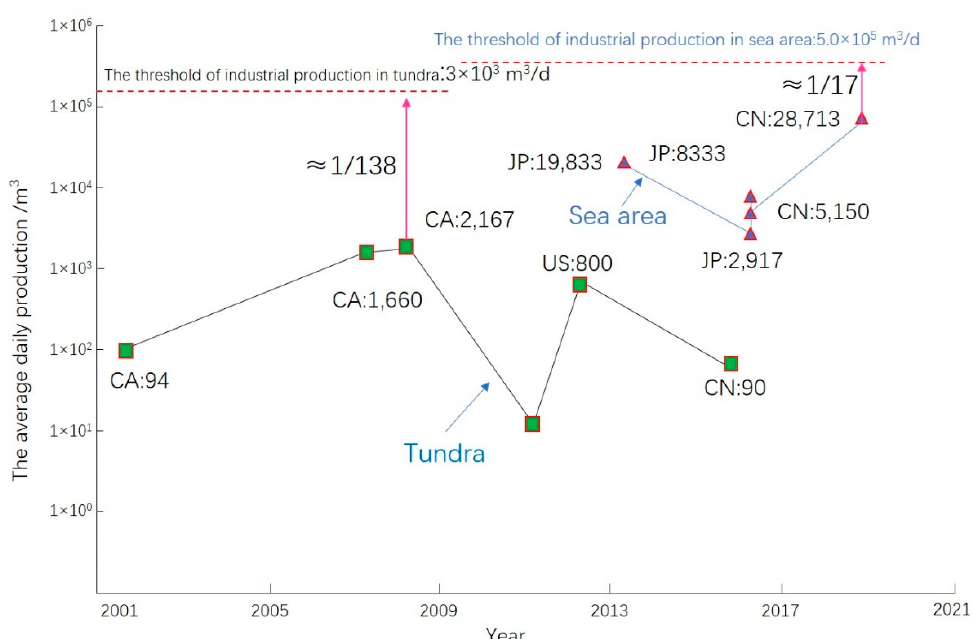
Figure 1. Relationship between average daily production test capacity and threshold of industrial production for NGHs (Reprinted with permission from Ref. [6]. 2020, Wu et al.).